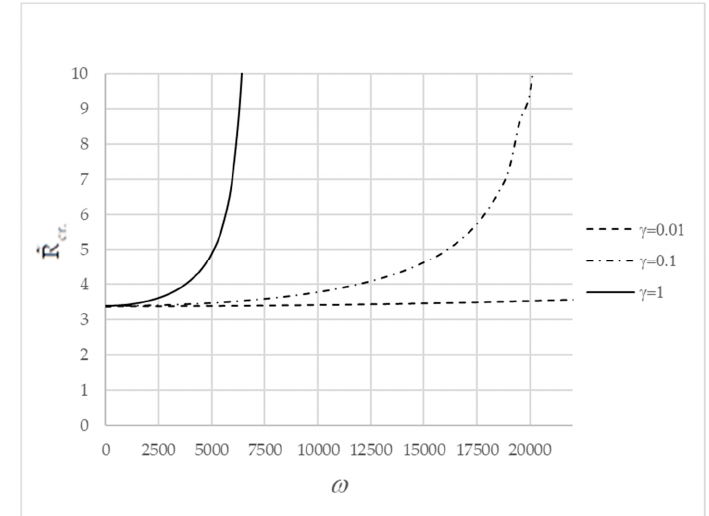
Figure 2. Case 3: Critical Rayleigh number versus vibration frequency for selected values of Vadasz number (A = − 0.5).